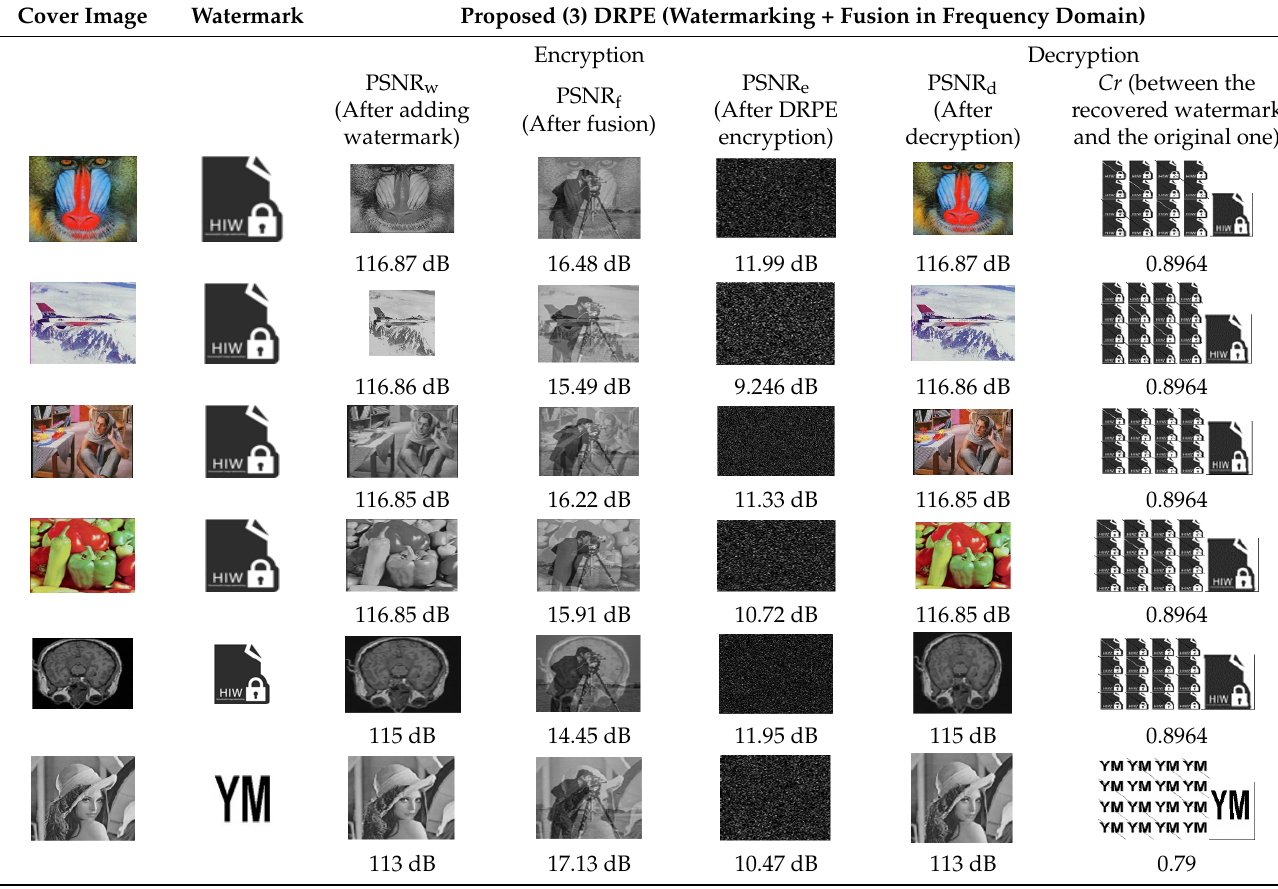
Table 2. Results of the third proposed technique based on DRPE.